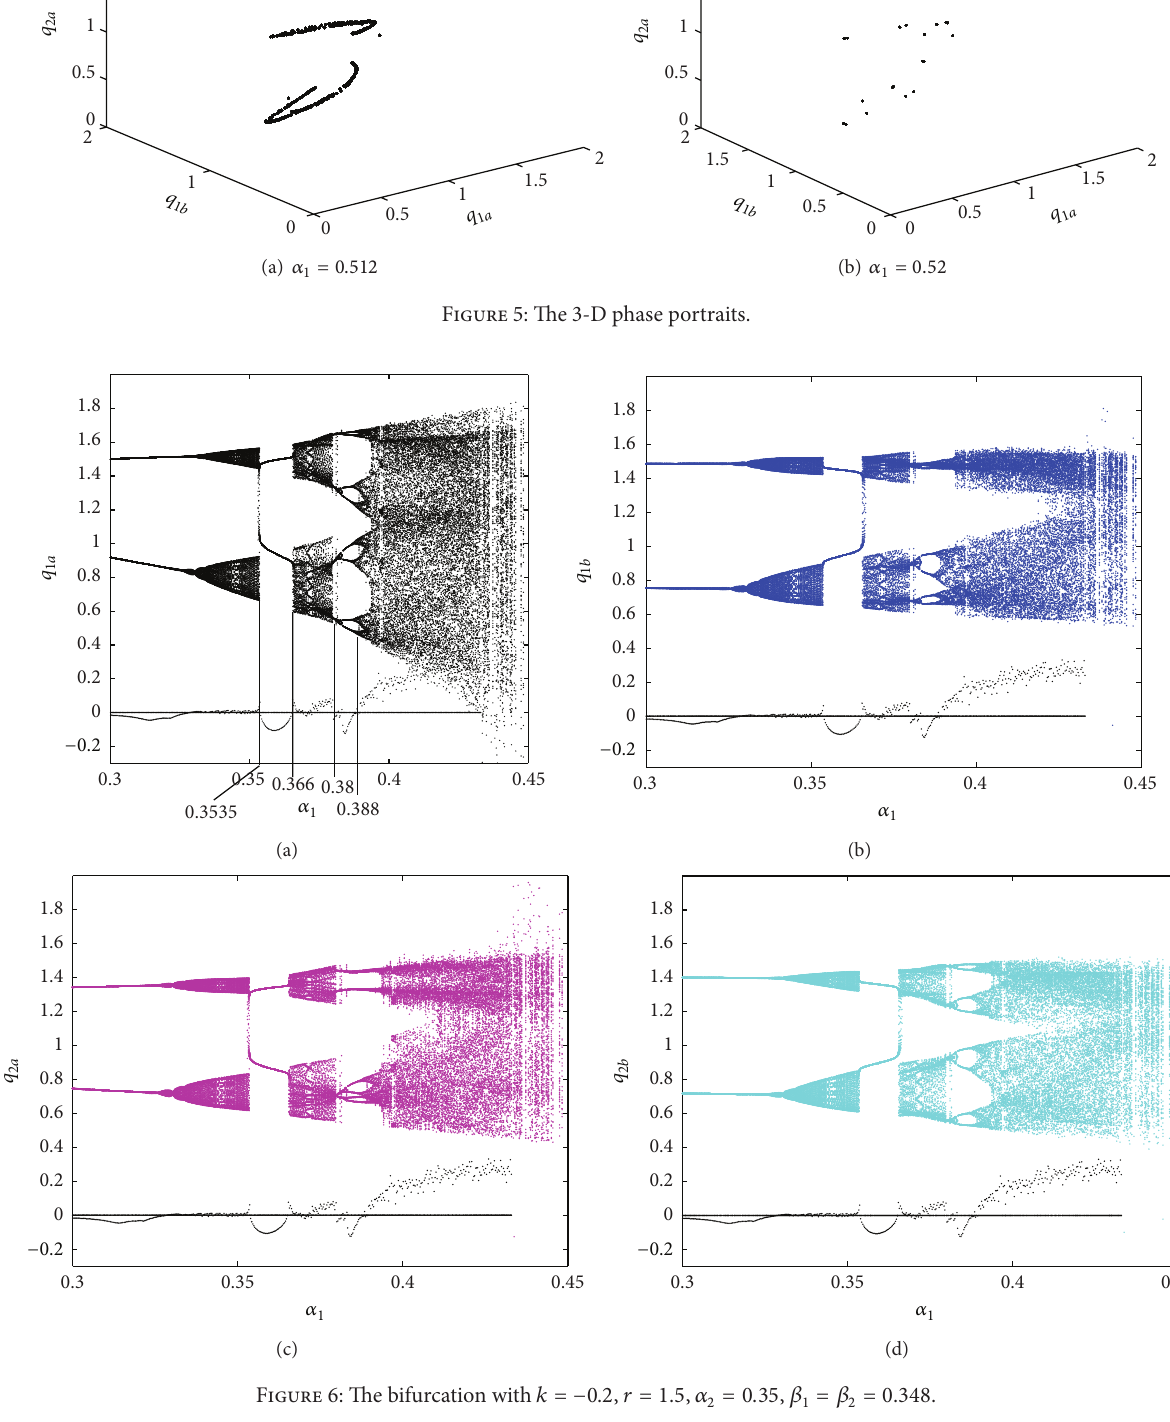
Figure 6: The bifurcation with 𝑘 = −0.2 , 𝑟 = 1.5 , 𝛼 2 = 0.35 , 𝛽 1 = 𝛽 2 = 0.348 .